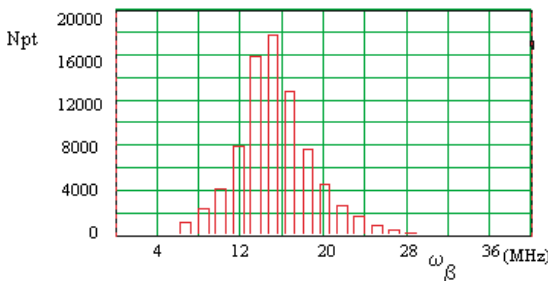
FIG. 9. (Color) Beam betatron frequency distribution with initial K-V particle distribution for s (cid:5) s 0 (cid:2) 0.29 . The odd mode half frequency, v o , is 32 MHz and the even mode half frequency, v e , is 42 MHz. They are both outside of the spectrum.